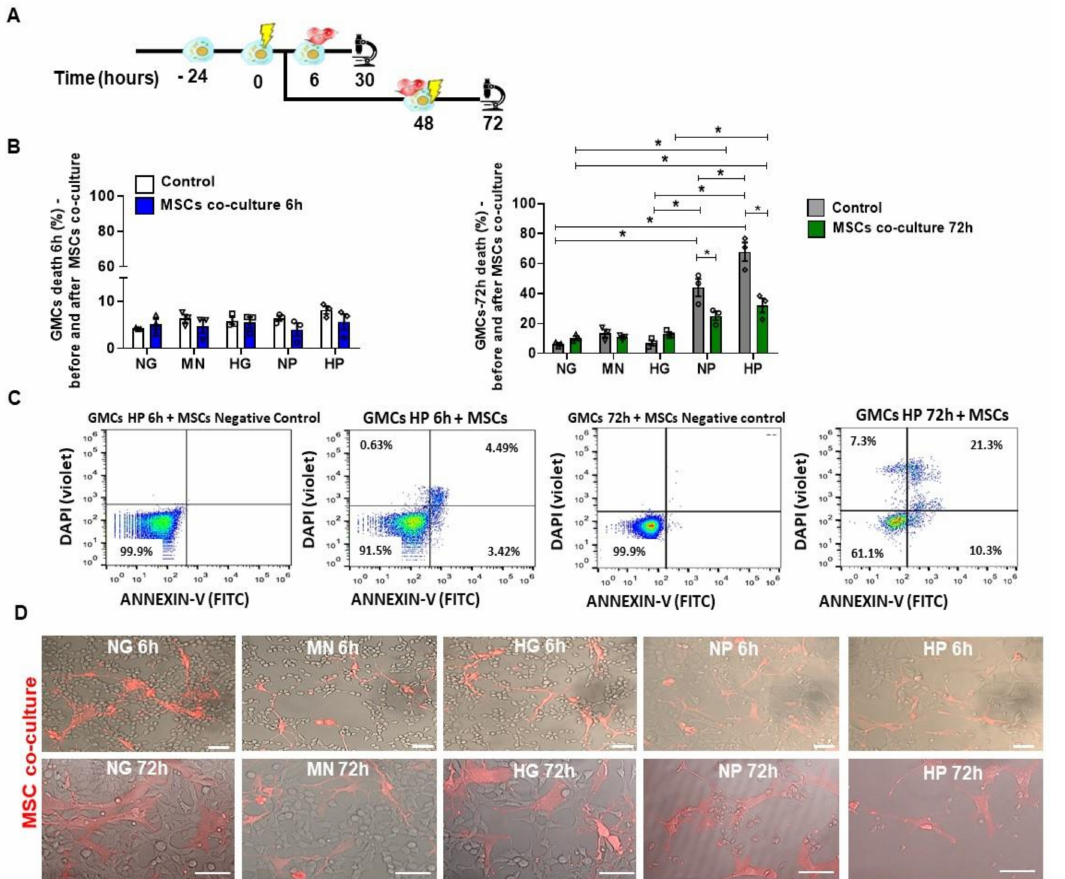
Figure 5. Pro-survival effect of MSCs co-culture on stress-conditioned GMCs. ( A ) Scheme of the cellular experiments for GMC conditioning with stress media-conditioning at different time-points (6 h and 72 h) and the subsequent MSCs co-culture therapy (24 h). ( B ) Flow cytometry analysis of GMC death (%) after MSC co-culture at 6 h and 72 h time-points, respectively. MSCs co-culture diminished GMCs’ death (%) after 72 h stress-conditioning with NP and HP media (* p < 0.05). ( C ) Flow cytometry gating and negative control for GMCs conditioned to HP at 6 h and 72 h time-points, with Annexin-V and DAPI staining. ( D ) Confocal images of MSC co-culture with stress media-conditioning at different time-points (6 h and 72 h). Scale bars represent 50 µ m. Cell death (FITC + and DAPI + ) in GMCs conditioned to stress media (normal glucose—NG, mannitol—MN, hyper glucose—HG, normal glucose + hydrogen peroxide—NP, hyper glucose + hydrogen peroxide—HP) during 6 h and 72 h time-points. Error bars represent mean ± SEM; n =